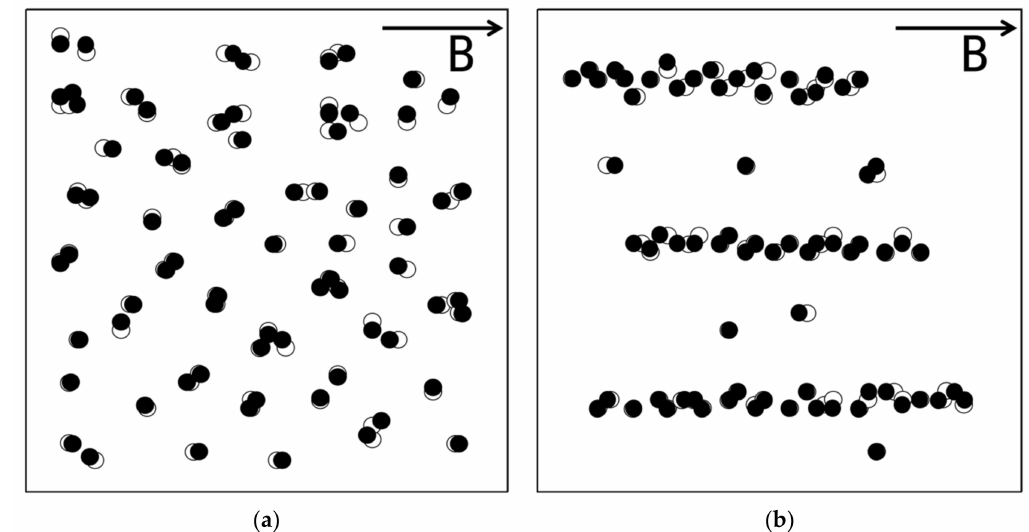
Figure 4. The two dimensional projections of the representative volume elements for ( a ) unstructured and ( b ) structured films on a surface perpendicular to the light beams used in the transmittance testing under an external magnetic